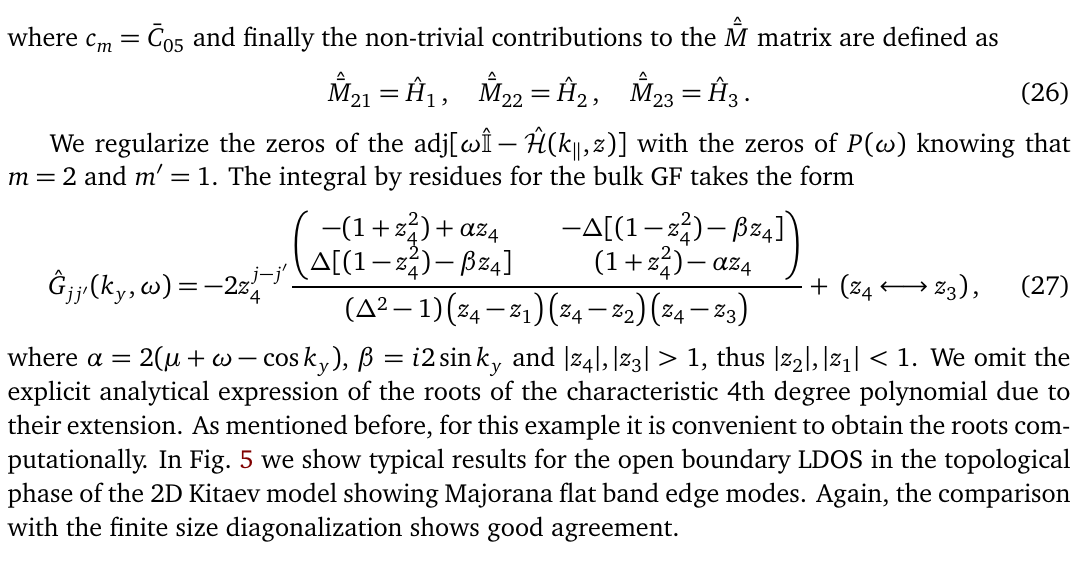
Figure 5: Open boundary characterization for the 2D Kitaev model showing Majorana flat band edge modes in the topological phase ∆ = 1 and µ = 1. a) Electronic bands obtained by exact diagonalization of a finite size system with N spectrum shows flat bands at both ends of the system. b) Spectral density for a right boundary in the semi-infinite limit obtained from the bGF calculation. c) Integrated LDOS where straight (dot-dashed) line represents bulk (right boundary)